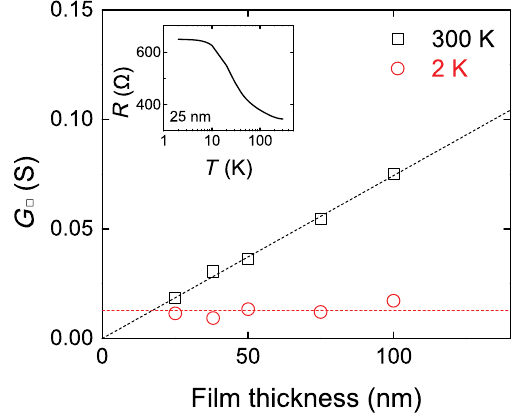
FIG. 1. Sheet conductance ( G □ ) of SmB 6 thin films at 2 and 300 K as a function of film thickness. Dashed lines are linear fits to the experimental results. The slope of 300 K data represents 3D bulk conductivity at 300 K in SmB 6 thin films, and the fit to the data (black dot line) extrapolates to zero at zero thickness, consistent with the fact that the conduction in SmB 6 thin films is dominated by a 3D bulk transport at 300 K. At 2 K, G □ is independent of the thickness, and the guide line (red dotted line) is the fit to the data, which indicates the average value of G □ at 2 K. The inset shows resistance versus temperature curve for a 25-nm SmB 6 thin